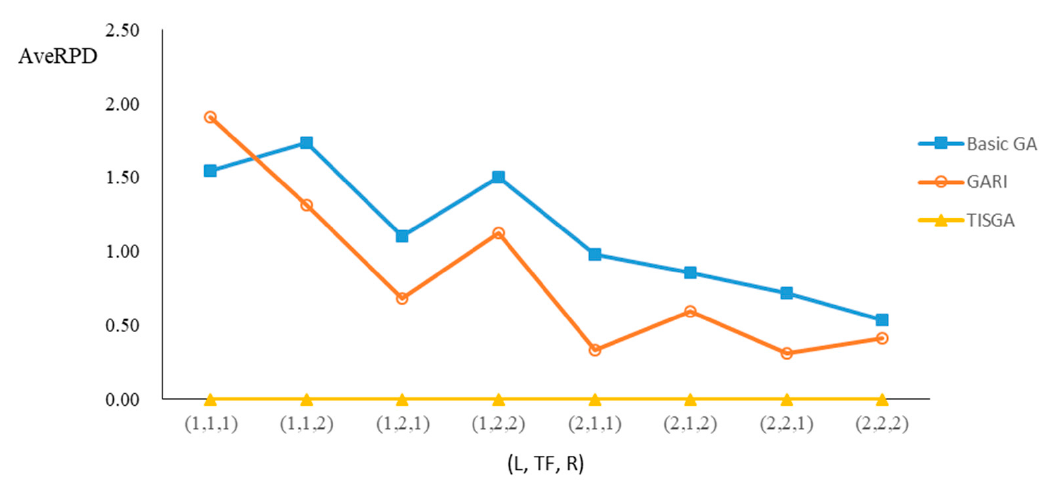
Figure 12. Comparison results for n = 40 with eight combinations of (L, TF, R).